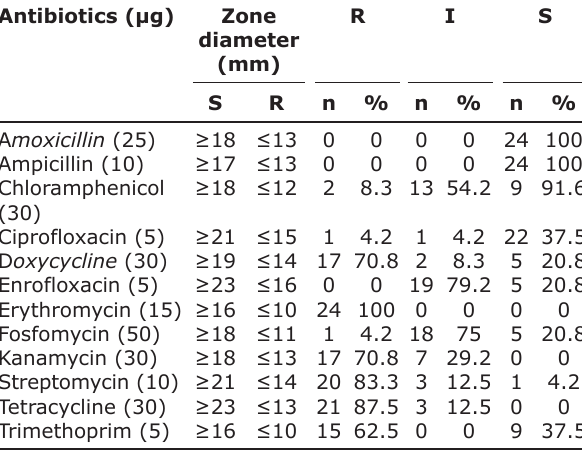
Table-2: The results of sensitivity test of Avibacterium paragallinarum isolates from layers against 12